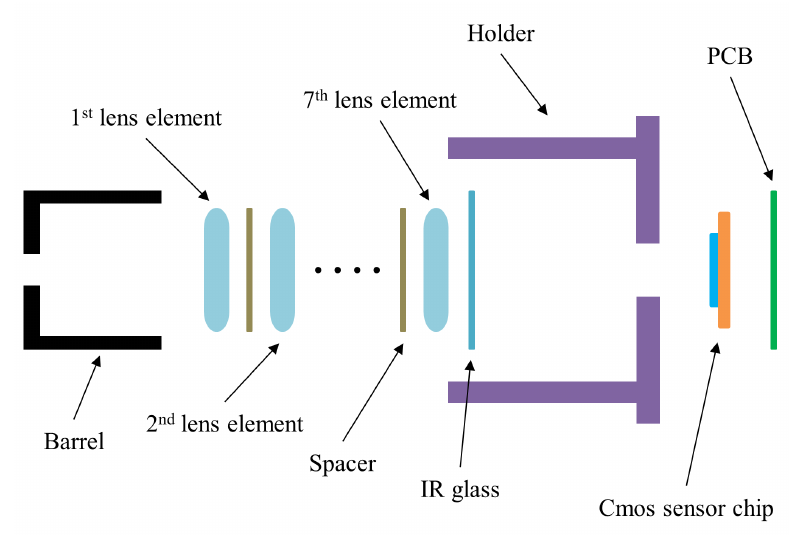
Figure 1. Exploded view of camera lens